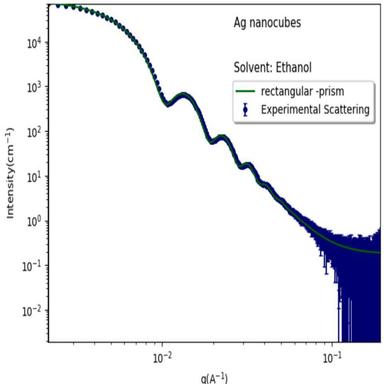
SAXS scattering data (dark blue) and rectangular prism model fit (green) for a rectangular prism with all sides the same length (75 nm). Sample is commercial silver nanocubes in ethanol (data from). (For interpretation of the references to colour in this figure legend, the reader is referred to the web version of this article.)